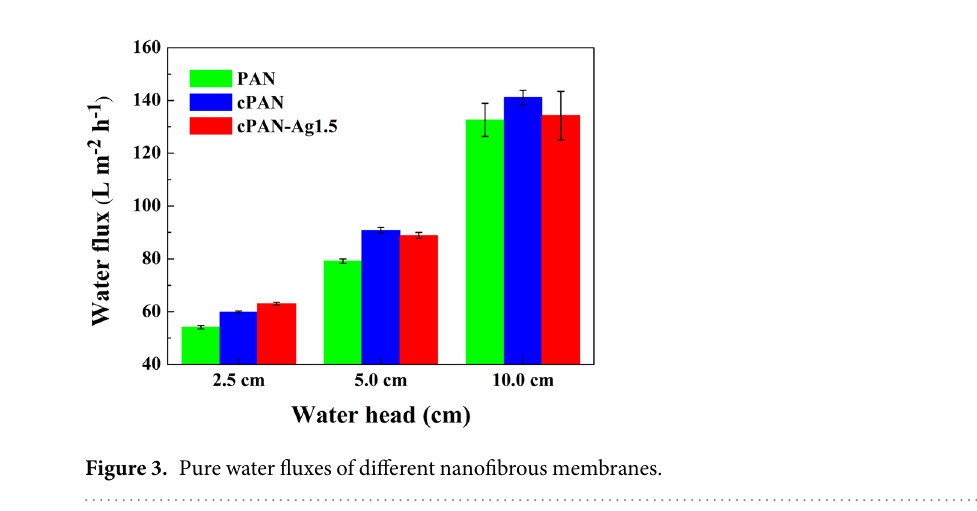
Figure 2. SEM micrographs of PAN ( a ), cPAN ( b ), cPAN-Ag0.5 ( c ), cPAN-Ag1.0 ( d ), and cPAN-Ag1.5 ( e ) nanofibrous membranes (scale bar is 100 nm).